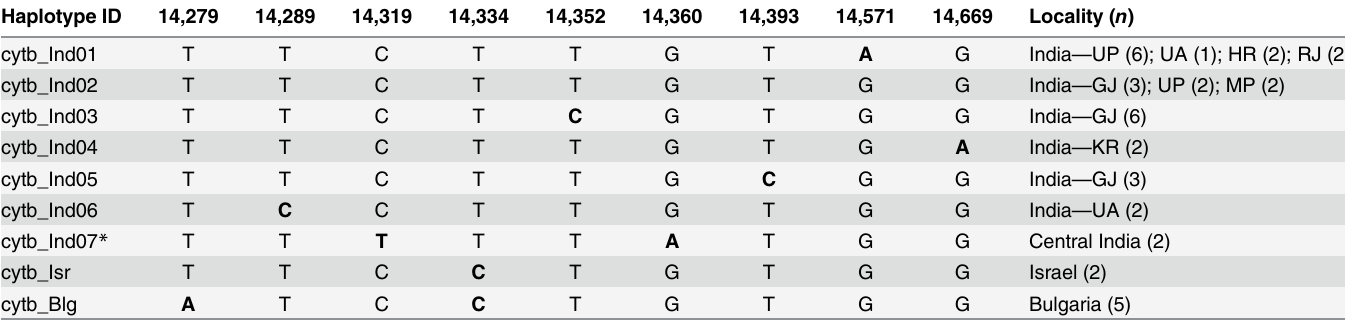
Table 2. Variable sites and haplotype frequency at the cytochrome b (cyt b ) gene in golden jackals. Numbers above each nucleotide base represent nucleotide positions relative to the complete mtDNA genome of Canis lupus lupus (GenBank Accession ID — NC009686). Sampled Indian localities are Uttar Pradesh (UP), Uttarakhand (UA), Haryana (HR), Rajasthan (RJ), Gujarat (GJ), Madhya Pradesh (MP) and Karnataka (KR). Refer S2 Table for specific sam- ple and locality information.